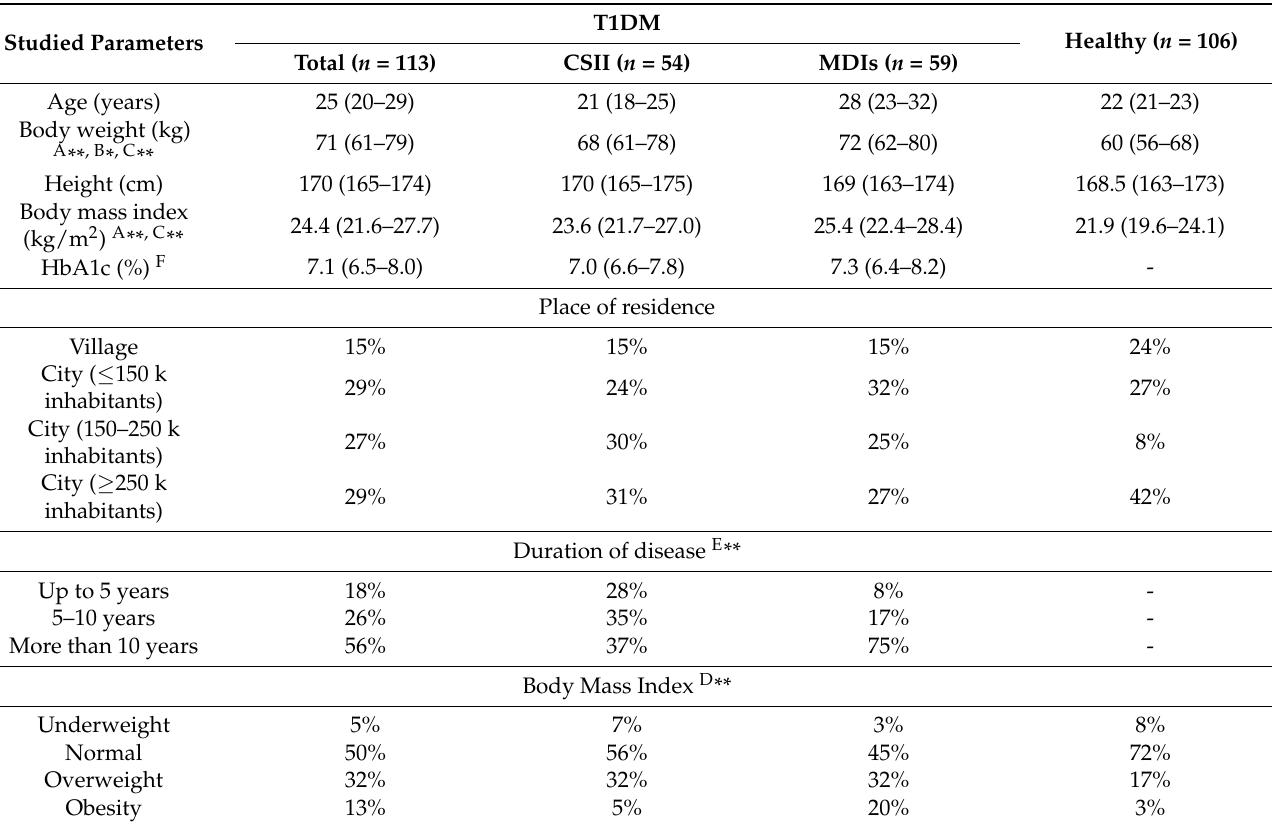
Table 2. Baseline characteristic of study